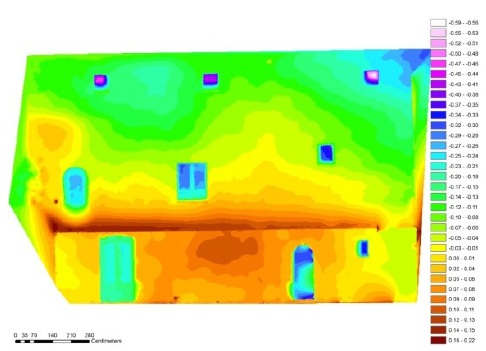
Figure 9: Verticality DSM (North-East)